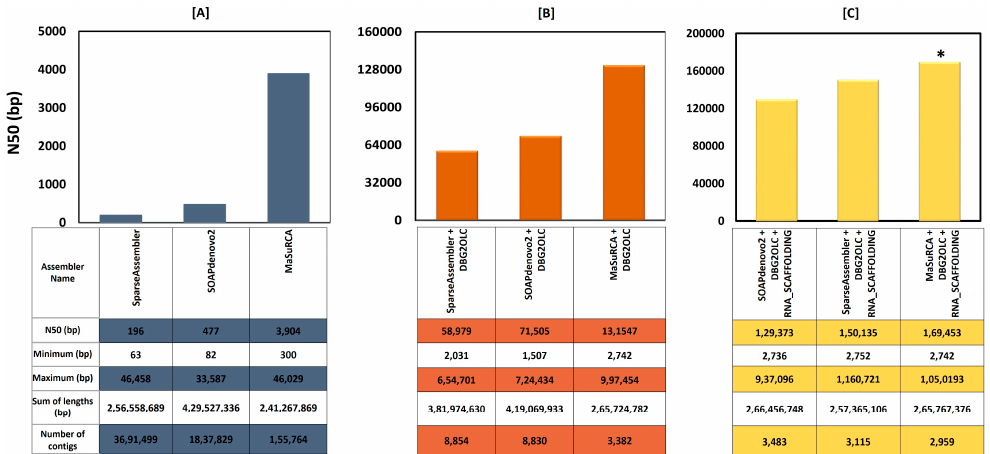
Figure 1. Statistics of the assemblers used in our study for ( A ) single assembly (in blue), ( B ) hybrid assembly (in orange), and ( C ) hybrid assembly with RNA scaffolding (in yellow). The table below the bar chart shows the statistics for each of the assembler(s). The combination of assemblers marked with a star (*) was used for our analysis. Table 1. Statistics of the hybrid assembly with a combination of MaSurCa, DBG2OLC, and RNA scaffolding. BUSCO: Benchmarking Universal Single-Copy Orthologs